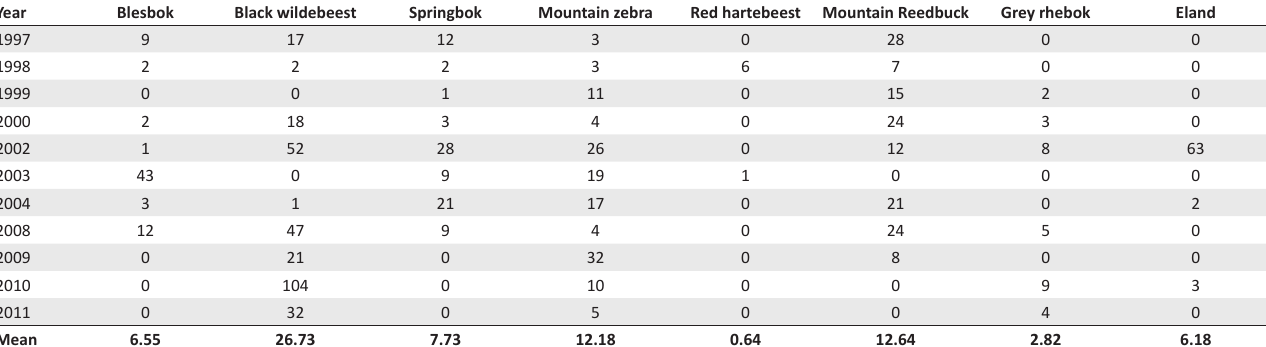
FIGURE 2: Mean percentage canopy cover of some dwarf shrub species in four pairs of plots compared between 1987 and 2009–2010 in fenced and unfenced plots: (a) Felicia fascicularis (dwarf shrub), (b) Helichrysum dregeanum (dwarf shrub) and (c) Chrysocoma ciliata (dwarf shrub). TABLE 3: Numbers of different species counted during the annual helicopter census in the Oudamme Valley from 1997 to